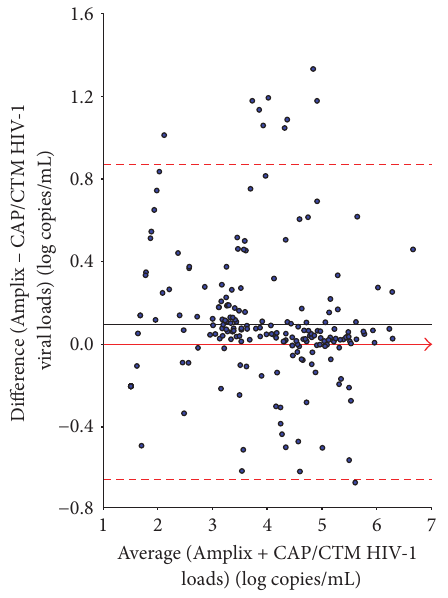
Figure 4: Bland-Altman agreement on the relative differences between the plasma HIV-1 RNA viral load measurements in 215 HIV-1-infected adults obtained in parallel by the HIV-1 RNA-based Amplix real-time PCR assay (Biosynex) and the reference COBAS AmpliPrep/COBAS TaqMan (CAP/CTM) HIV-1 test v2.0 (Roche Molecular Diagnostics). The full line represents the mean relative difference, and the horizontal dotted lines represent the superior and inferior limits of agreement [i.e., the mean differences ± 1.96 SD (SD = 0.377), representing the 95% confidence limits of the agreement]. There were 10 (4.6%) discrepant samples outside the 95% CI level of agreement between the results by HIV-1 RNA- based Amplix real-time PCR assay (Biosynex) and the reference COBAS AmpliPrep/COBAS TaqMan (CAP/CTM) HIV-1 test v2.0. The arrow corresponds to the 𝑥 abscise axis.